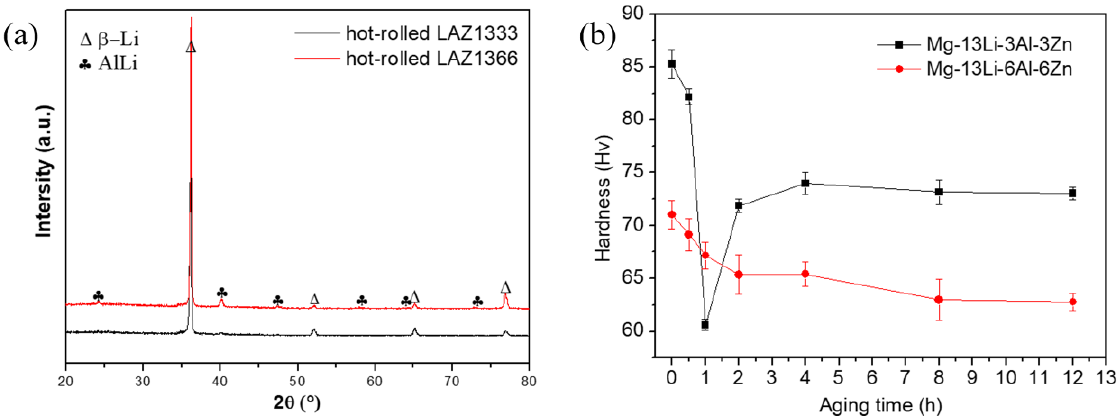
Figure 8. ( a ) XRD pattern of hot-rolled LAZ13 xy ( x = 3, 6 wt%, y = 3, 6 wt%) alloys, ( b ) aging hardening curves of the LAZ13 xy ( x = 3, 6 wt%, y = 3, 6 wt%) alloys at 100 °C.